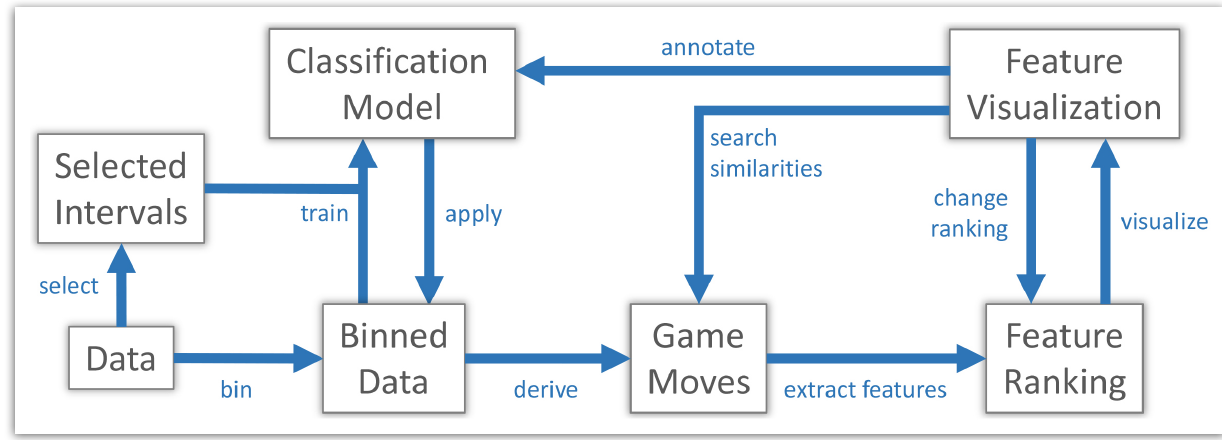
Figure 3. Novel visual analytics workflow to support experts in identifying and exploring interesting situations in team